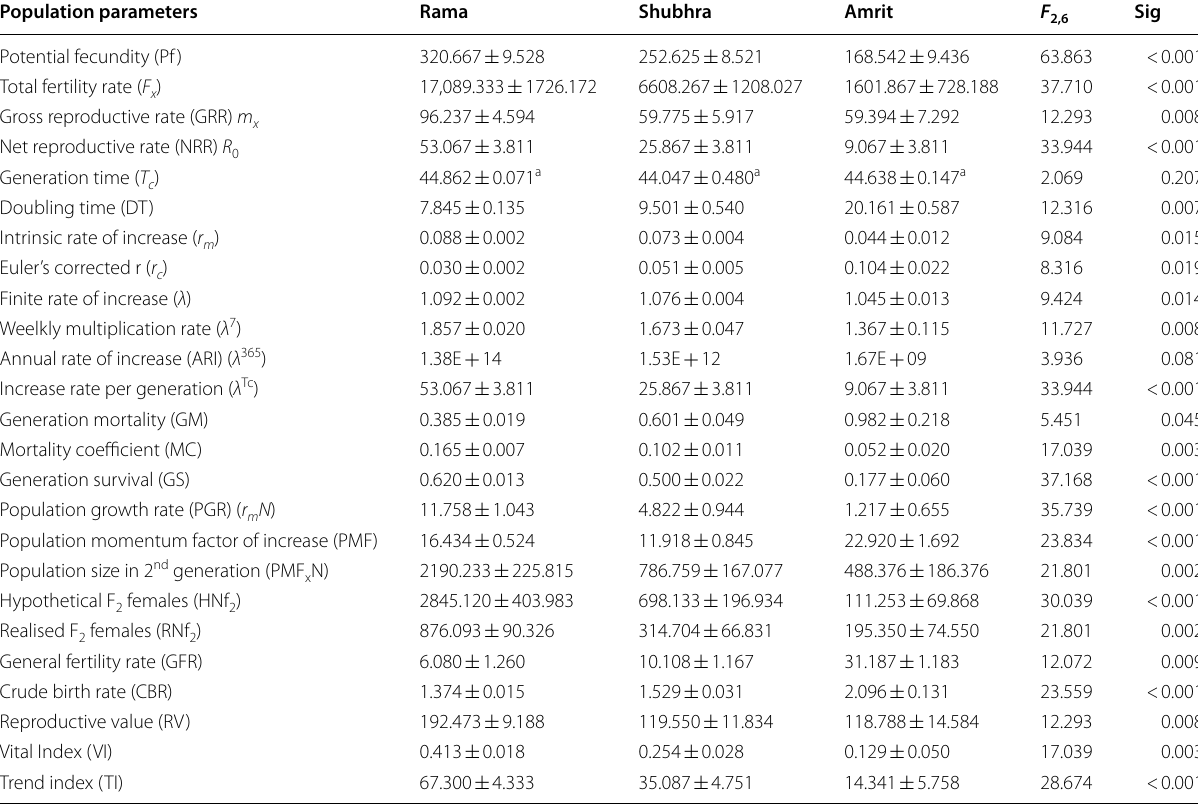
SE of 3 observations/cultivar) of the 9 cohorts (3 ±